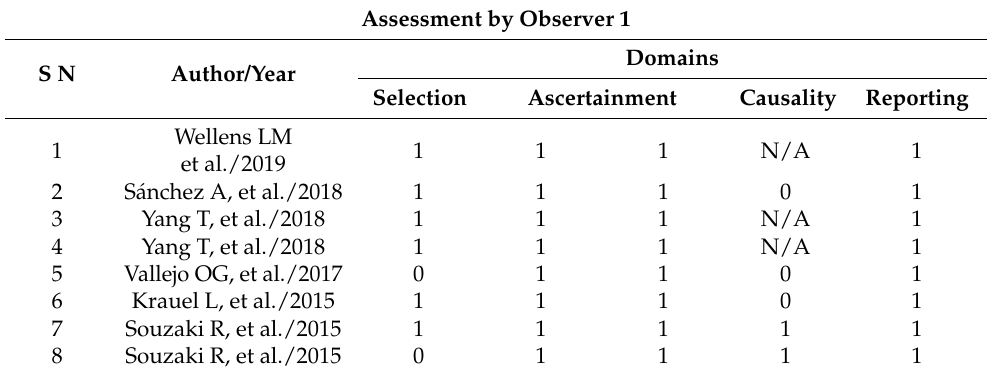
Table 3. Methodological quality assessment by two independent